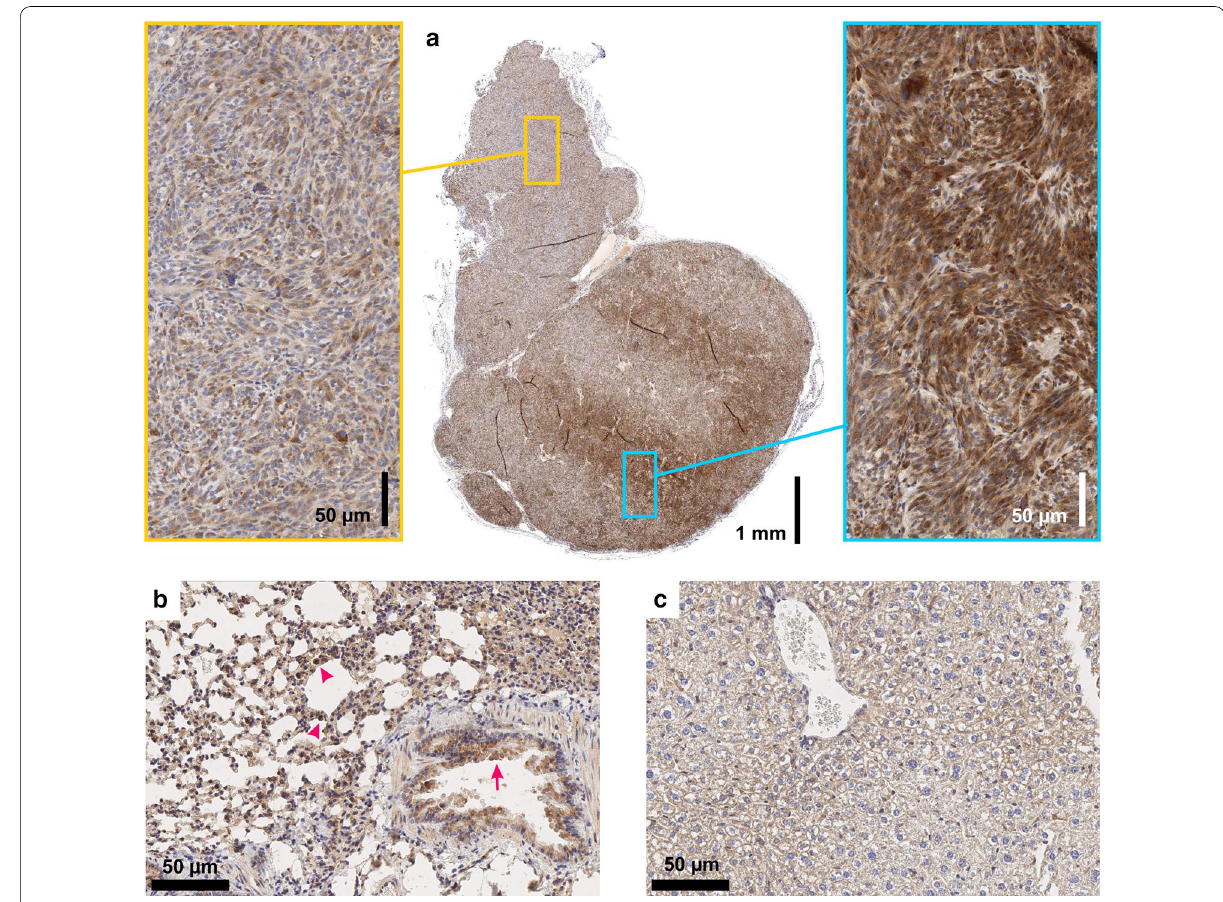
Fig. 5 β8 integrin immunohistochemistry (IHC) of MeWo tumor ( a ), lung ( b ), and liver tissue ( c ) of the same animal used for comparative PET scans (Fig. 6). Magnifications in yellow and cyan frames show MeWo areas with low and high cellular β8 integrin expression, respectively. A slight β8 expression is observed in the bronchiolar epithelium of lung (arrows) and alveolar macrophages (arrowheads). No β8 expression in liver tissue. Note that β8 integrin dimerizes only with the ubiquitous αv monomer, which is why β8 is limiting and indicative for actual αvβ8